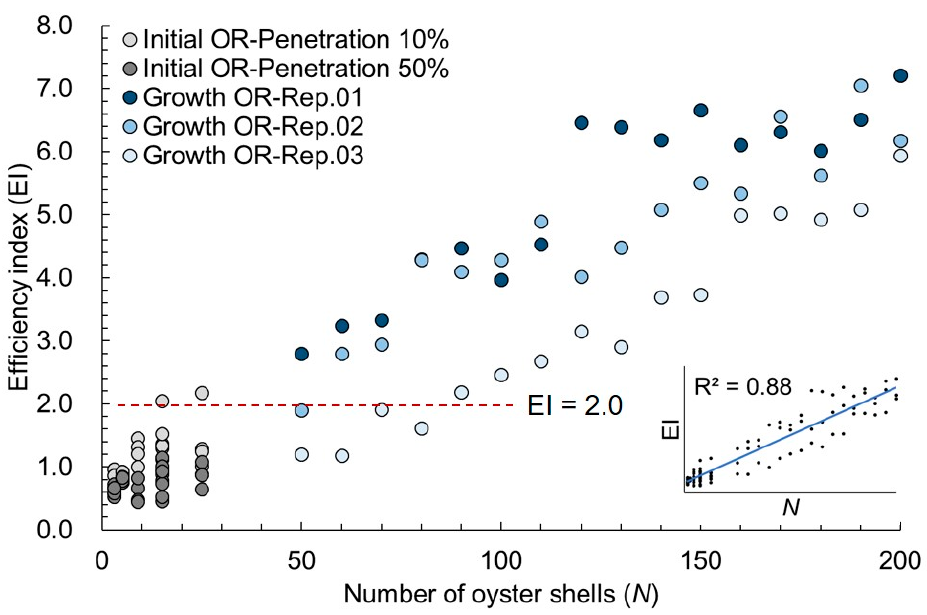
Figure 11. Correlation of the efficiency indices with number of oyster shells ( N ).